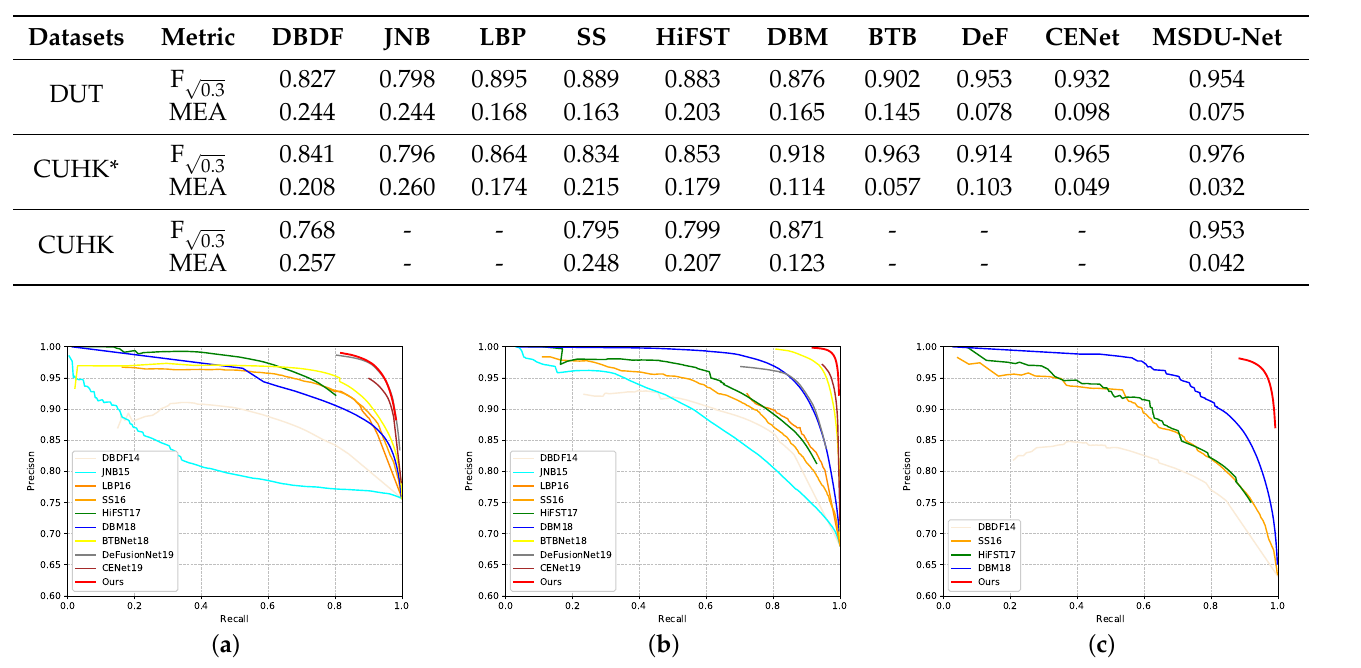
Table 1. Quantitative comparison of F √ -measure and MEA scores. The best results are marked in bold. CUHK* in the 0.3 table is the CUHK dataset excluding motion-blurred images, and “-” means that the methods are not designed for the motion blur. We compared these methods: DeF [34], CENet [32], BTBNet [40], DBM [33], HIFST [13], SS [17], LBP [12], JNB [16], and DBDF [7].